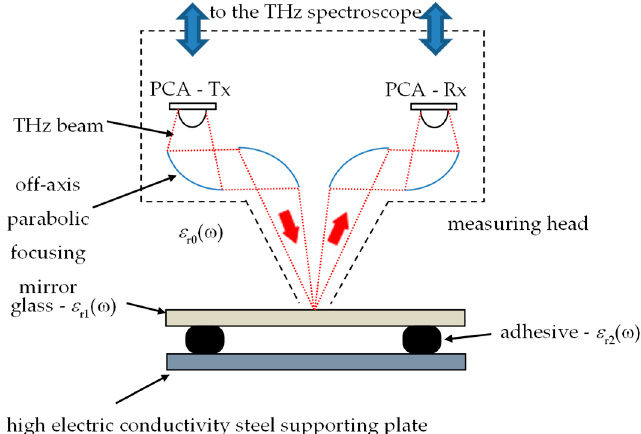
Figure 5. Scheme of measuring setup for terahertz imaging.